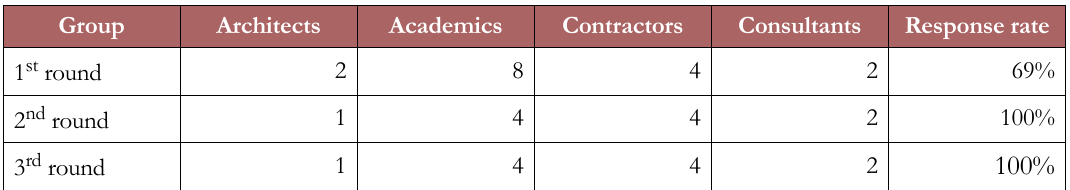
Table 4. Response Rates across the Participant Groups and